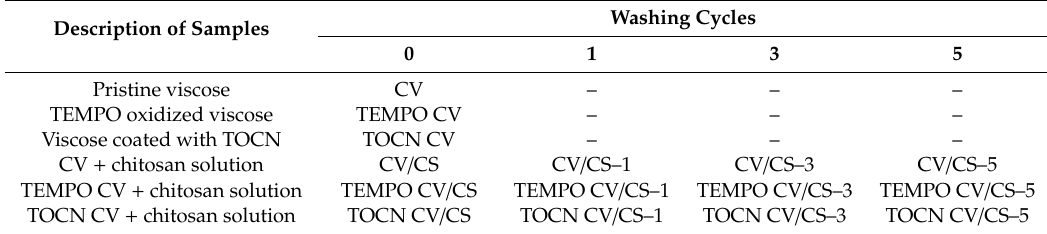
Table 1. Notation of the prepared